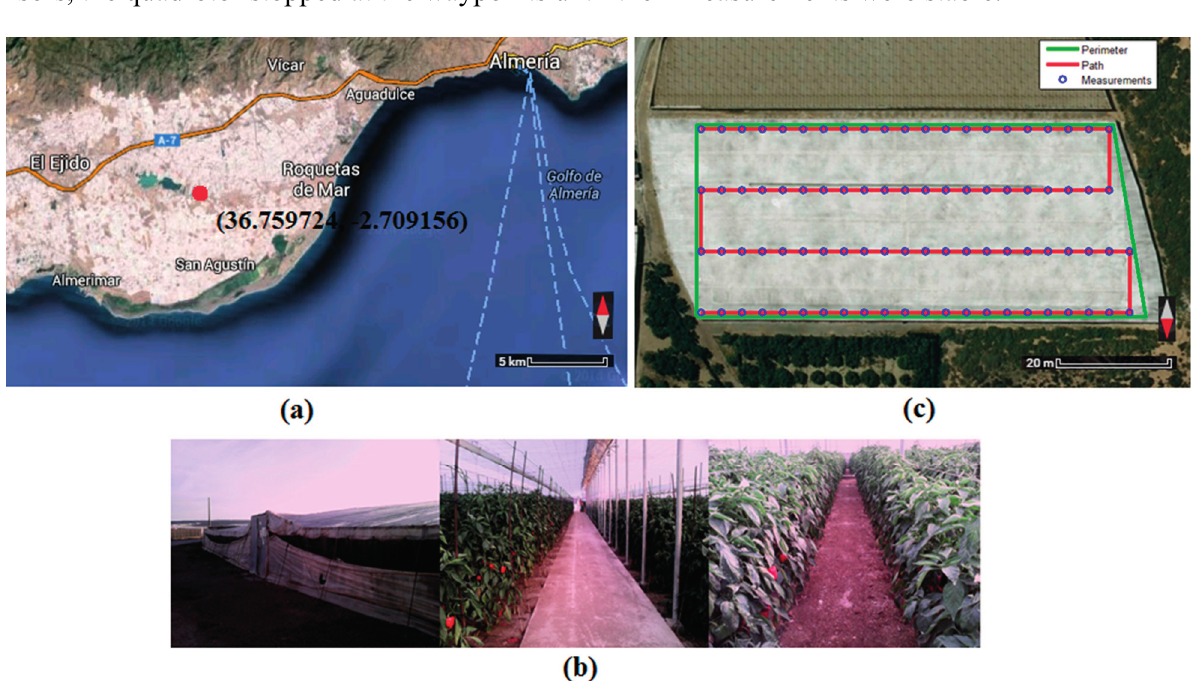
Figure 10. ( a ) The “sea of plastics” in Almería (Andalucía, Spain). Map data ©2014 Google, based on BCN IGN Spain; ( b ) Inside and outside of the greenhouse; ( c ) Top view of the greenhouse. Map data ©2014 Google, based on BCN IGN